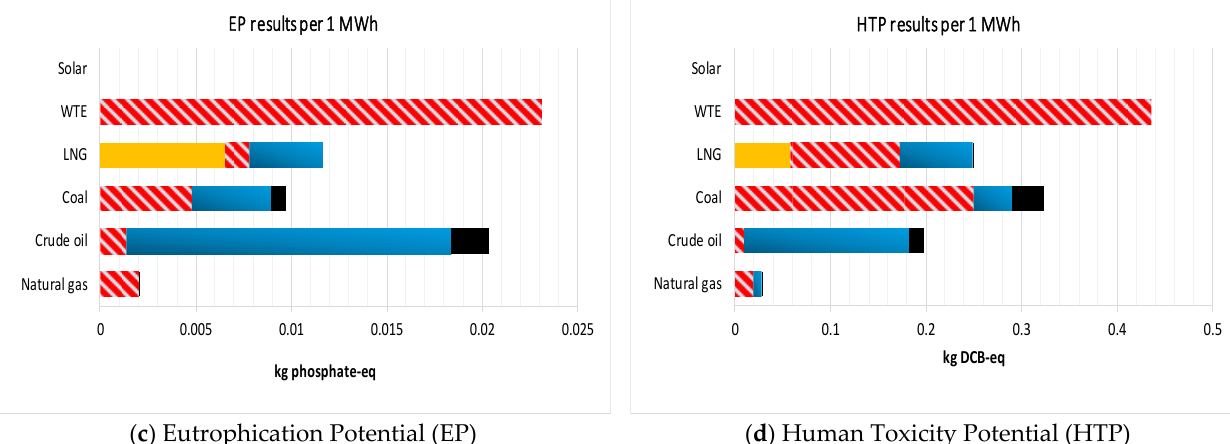
Figure 3. Preliminary assessment: environmental impacts.